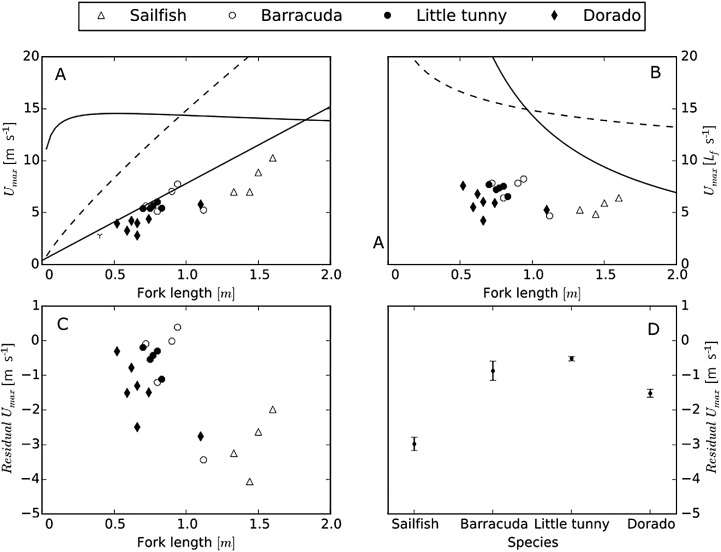
Estimated swimming performance in four species of large marine predators. (A,B) The calculated maximum attainable swimming speeds for the four species expressed in m s−1 (A) and in Lf s−1 (B). The broken curves represent the power limitation calculated from Iosilevskii and Weihs (2008) (150W kg−1) and the full curves represent an estimate of maximum swimming speed caused by the cavitation limit at shallow depth with a condition factor corresponding to that of bonito (Jin et al., 2015). The full line (in A) corresponds to the equation for maximal swimming speed (in m s−1) given by Videler (1993) (U=0.4+7.4 Lf). (C) Residuals [deviation from expected Umax based on Videler (1993)] as a function of Lf. (D) Residuals [deviation from expected Umax based on Videler (1993)] for each species, mean (±s.e.m.).